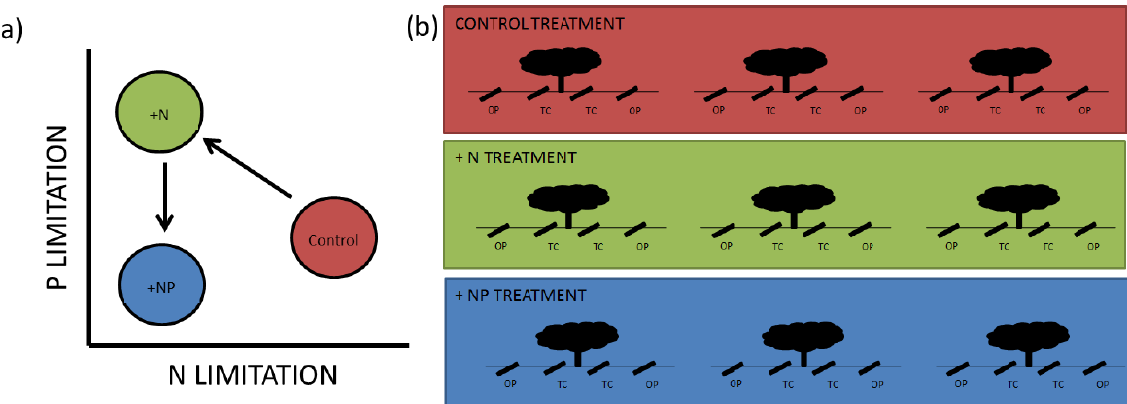
Figure 1. Schematic diagram of the experiment. In (a) , we show conceptual release from N limitation in our +N treatment but promotion of P limitation, which is alleviated by NP additions. In (a) we show 12 minirhizotrons per treatment, split between three trees into open-pasture (“OP”) and tree-covered (“TC”) areas. This is a small subset of the total trees in each footprint. The median distance between trees within treatment is 116m and the minimum distance between individual minirhizotrons is